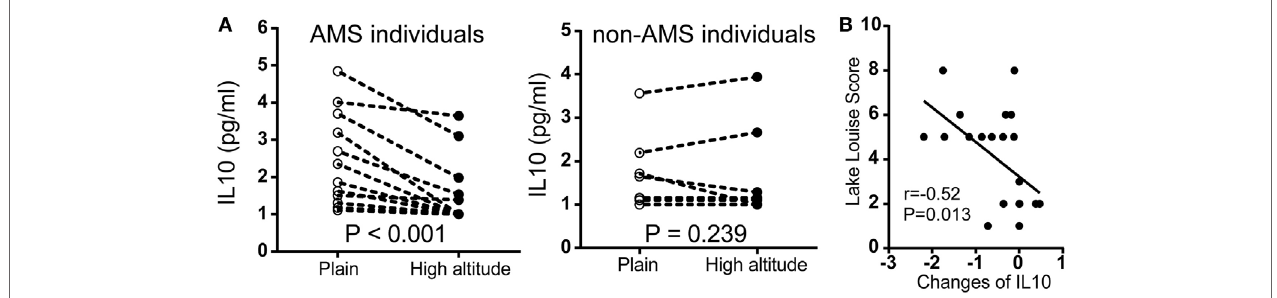
FigUre 5 | comparison of il10 protein expression in independent non-acute mountain sickness (aMs) and aMs individuals by paired t -test . (a) Illustration of IL10 expression in individuals with AMS ( N = 12) and non-AMS ( N = 10), respectively, before and after exposure to elevated altitudes. (B) Pearson correlation for the changes in IL10 concentration (IL10 concentration postexposure to high altitude − IL10 concentration preexposure to high altitude) and Lake Louise